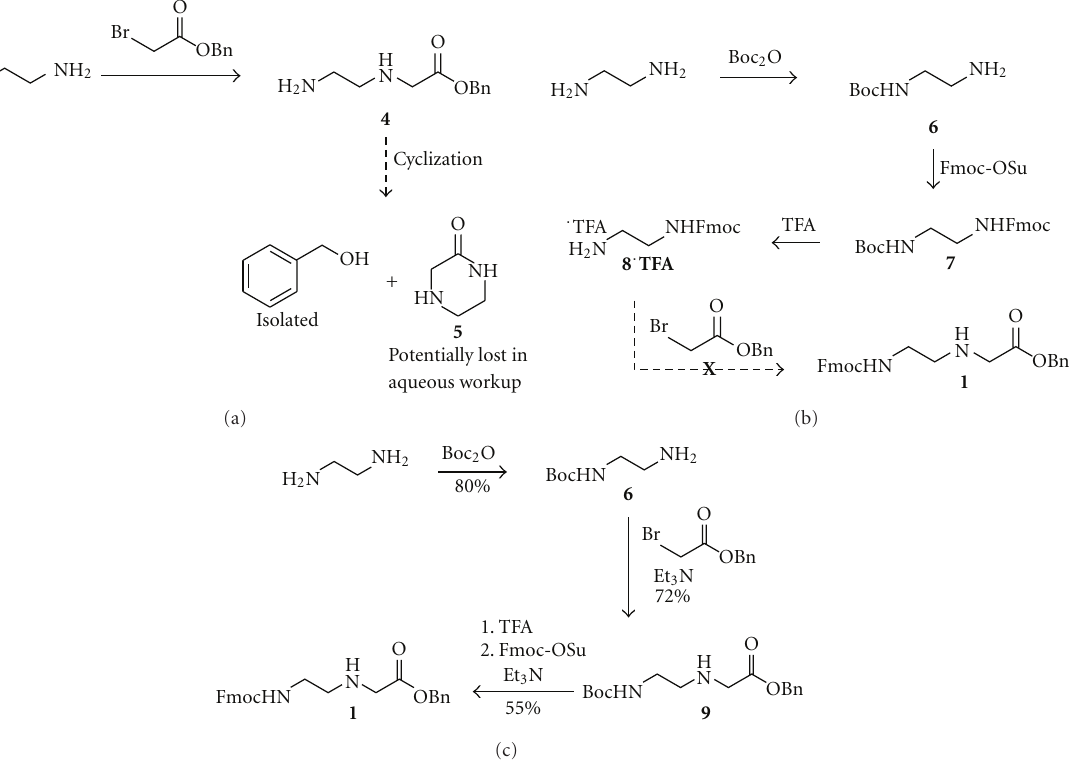
Figure 4: Synthetic route to Fmoc-AEG-OBn